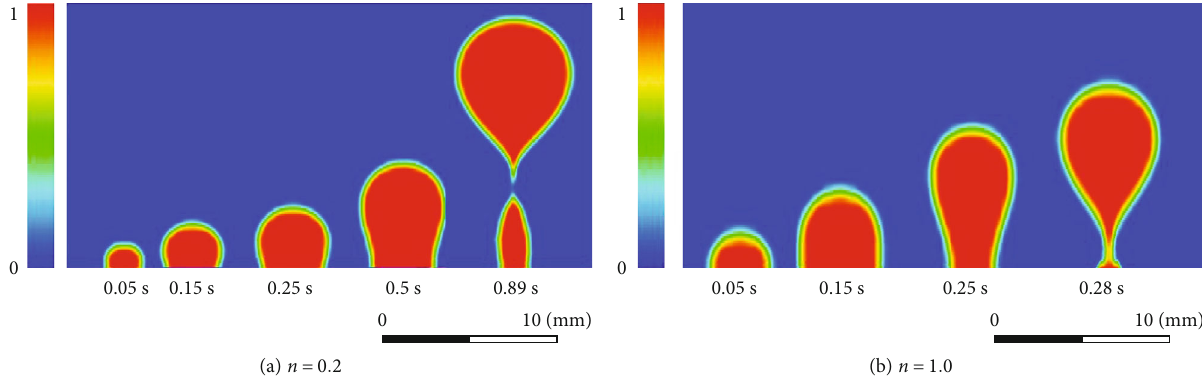
Figure 10: Bubble formation and escape processes in liquids with di ff erent n .